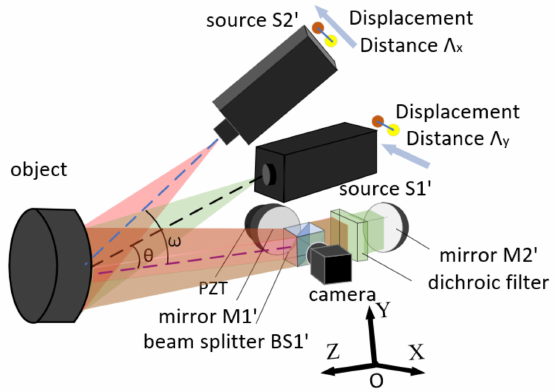
Figure 3. Two-dimensional color shearography with source